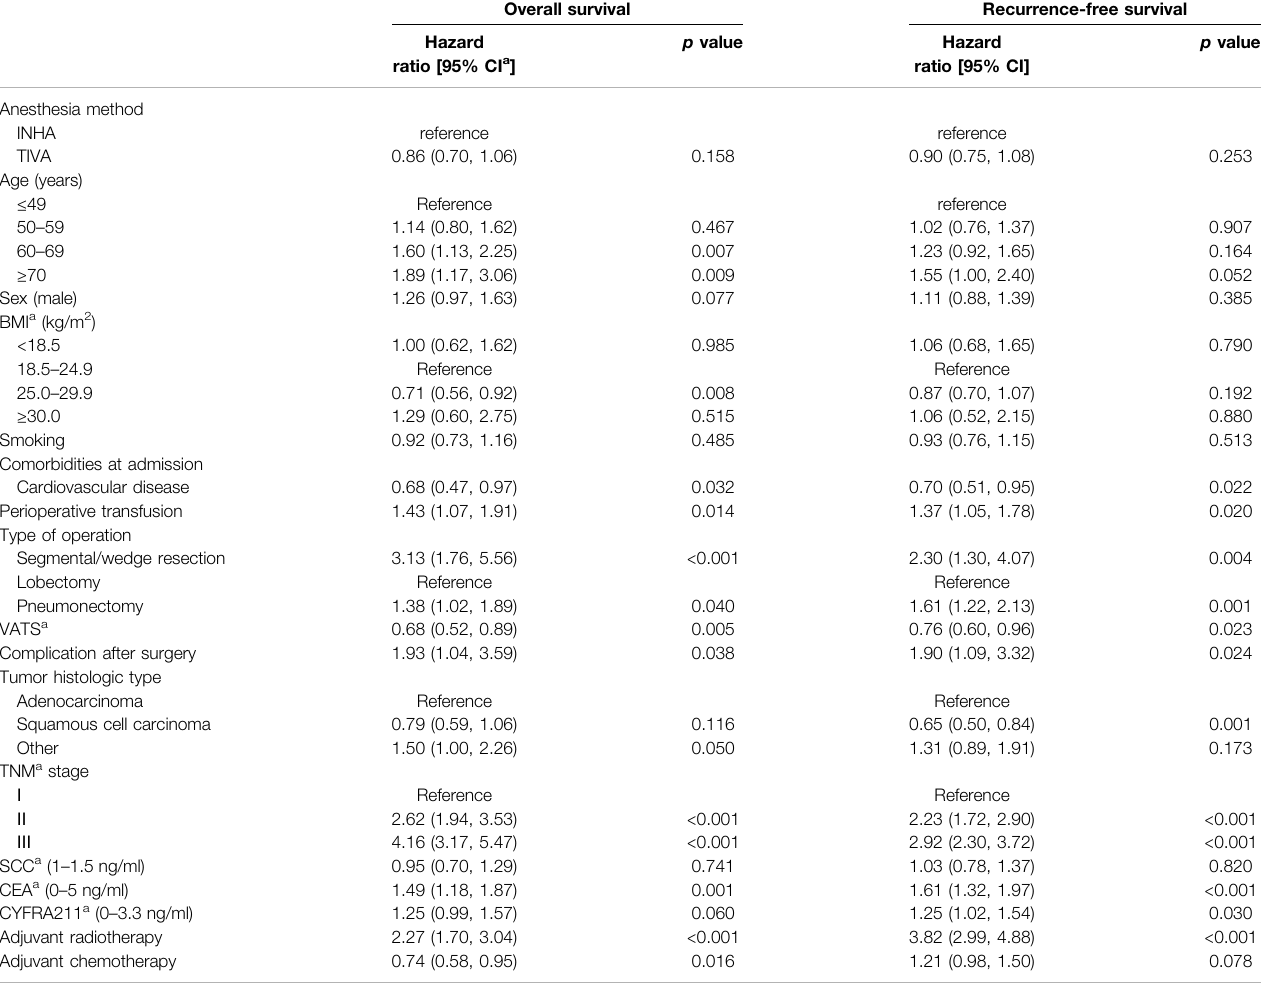
TABLE 2 | Multivariable Cox regression analysis for overall survival and recurrence-free survival after propensity score